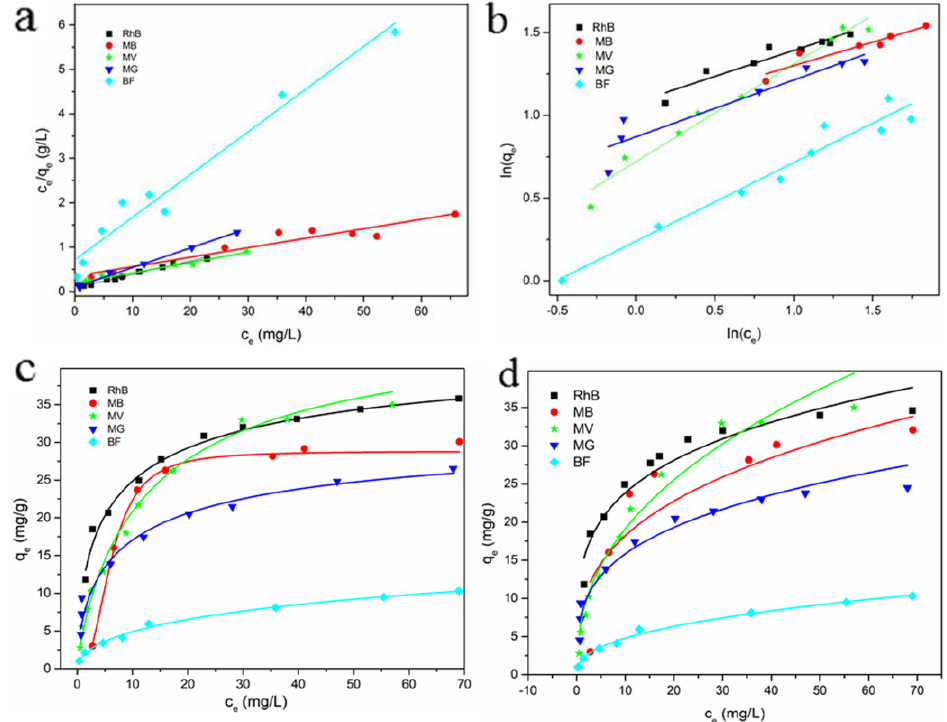
Figure 4. Adsorption isotherm models of MSNs for adsorption of cationic dyes with the Langmuir model ( a ), Freundlich model ( b ), and plot of adsorption capacity ( q e ) vs. equilibrium concentration of MSNs for adsorption of cationic dyes according to the Langmuir model ( c ). Table 1. Langmuir and Freundlich parameters for the adsorption of cationic dyes onto MSNs at 25 ◦ C.